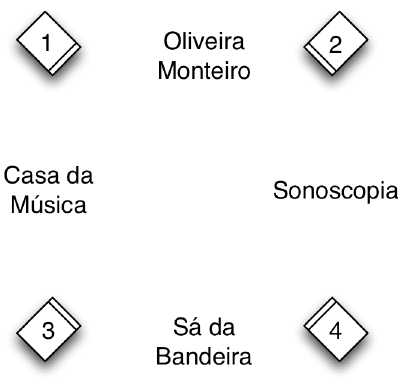
Figure 5 | Source spatial position configuration.